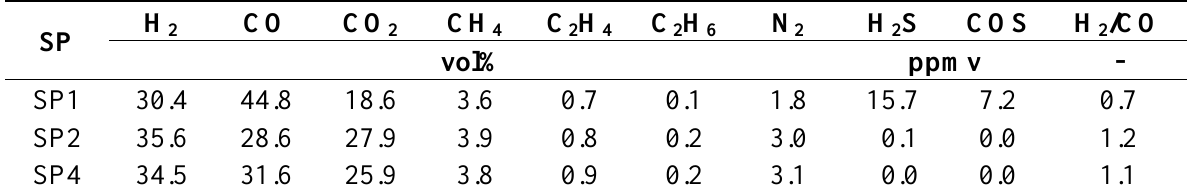
Table 4. Gas composition at SP1, SP2, and